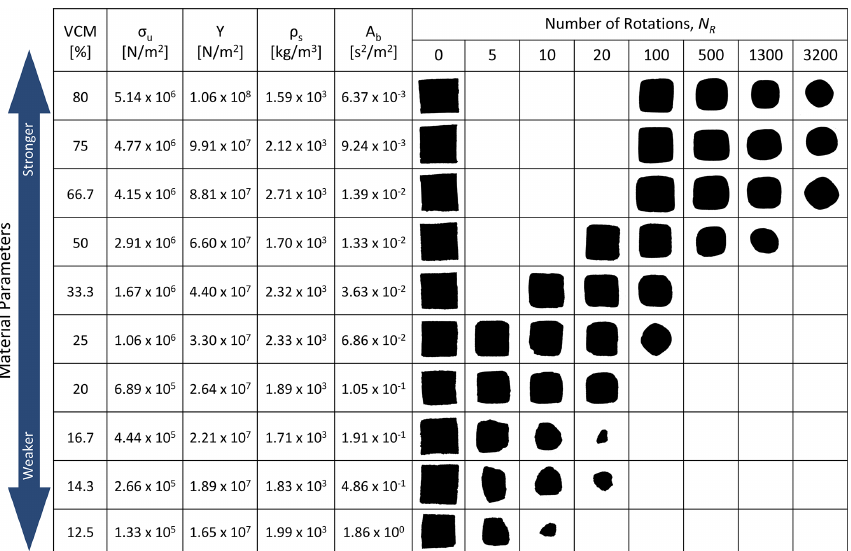
Figure 9. Progression of particle breakdown according to material parameters and approximate number of impacts; N i = 0 indicates the initial shape of the particle. The material parameters of each particle type are indicated using VCM, average ultimate strength ( σ u ) and modified Young’s modulus ( Y ∗ ) as measured through Instron compression tests, and average brittle attrition number ( A b ). Also shown is particle density ( ρ s ), which does not vary systematically with material strength. Mechanically strong particles achieved highly rounded shapes over thousands of rotations, while mechanically weak particles quickly fragmented into irregular shapes over 10–20 impacts. Intermediate particles exhibited both behaviors.